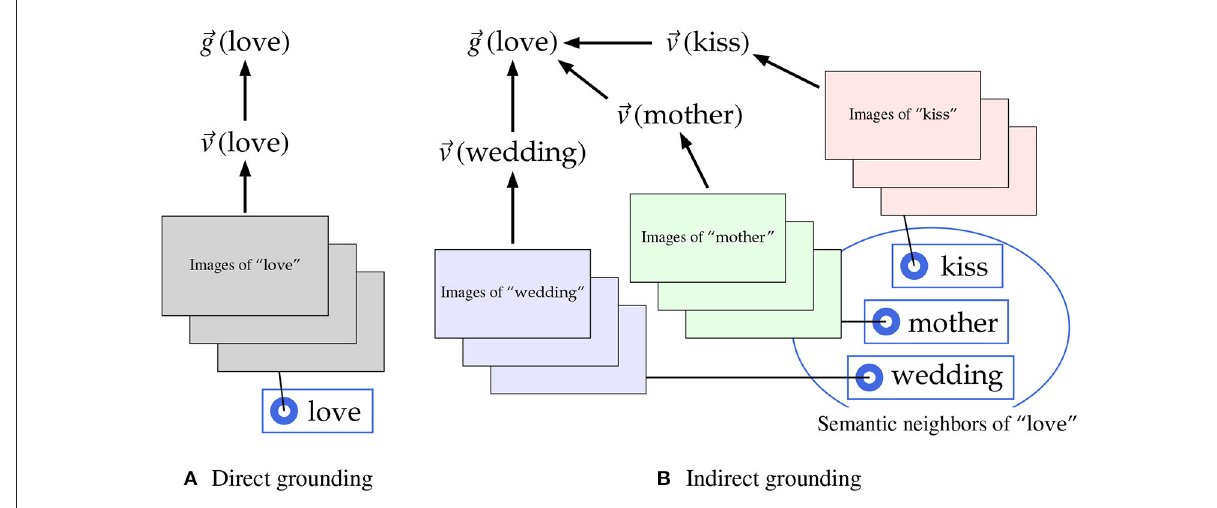
FIGURE1 Two methods to compute the visual vector in the multimodal distributional semantic model for indirect grounding. (A) Direct grounding. (B) Indirect grounding.